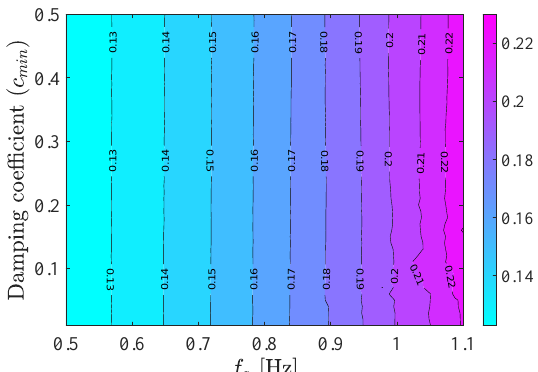
Figure 12. J 3, RMS for energy-controlled FPS+SD under the design